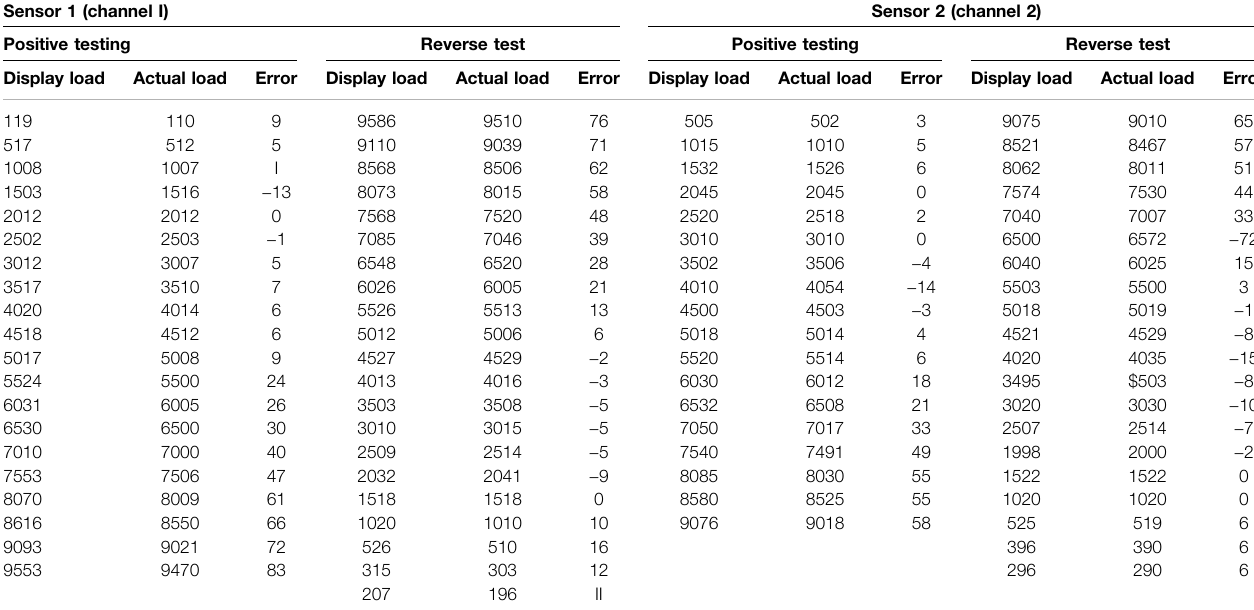
TABLE 3 | Comparison of data sets.